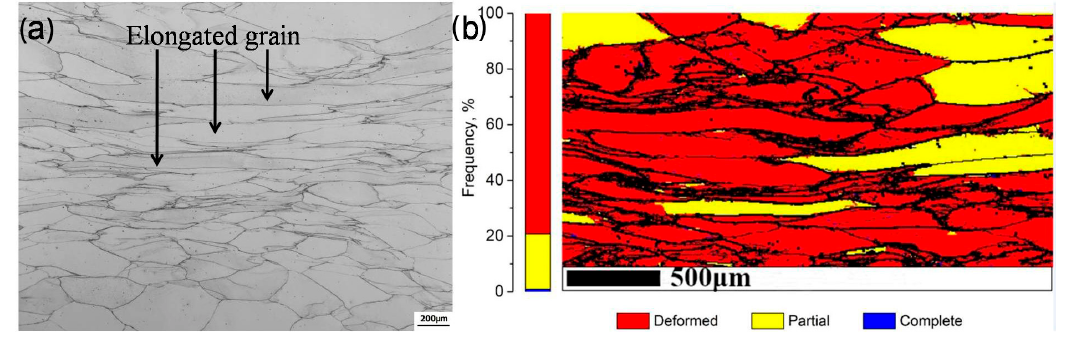
Figure 13. ( a ) microstructure; ( b ) recrystallized fractions of Domain 4 at the true strain of 0.7.